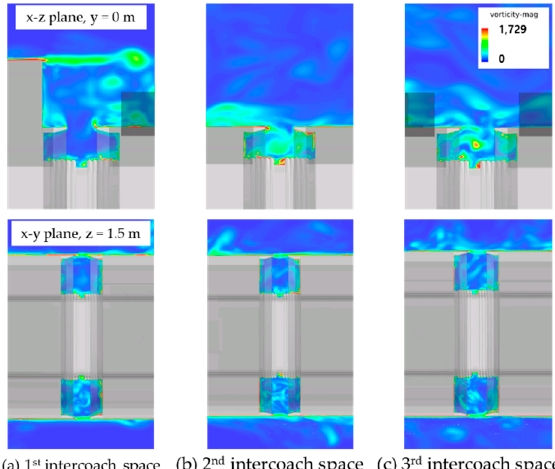
Figure 13. Instantaneous vorticity magnitude contours of intercoach regions at y = 0 m.